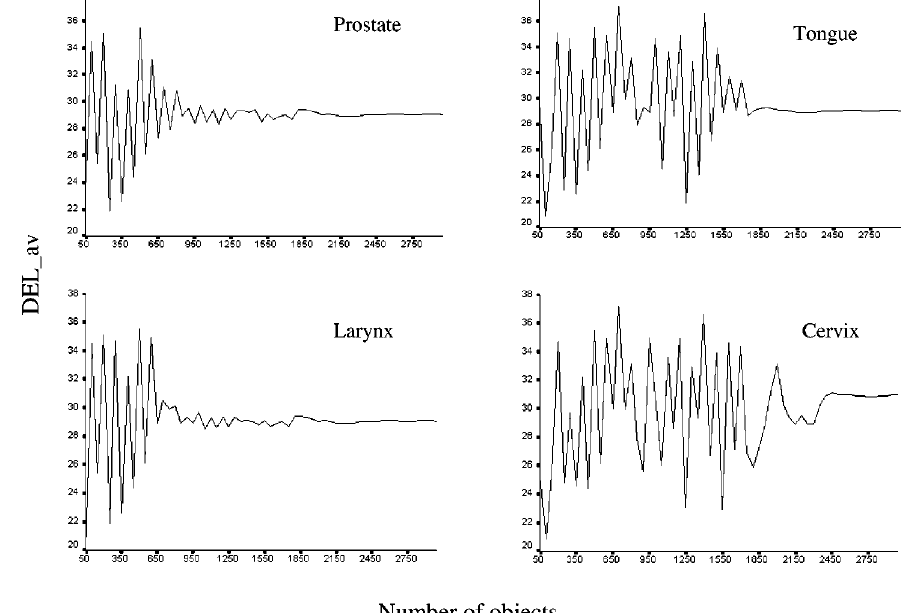
Fig. 2. The absolute values of the form parameter DEL_av as a function of the number of cells analyzed in four different tissues (carcinoma of the prostate, tongue, larynx and cervix). The number required to achieve reproducible values for a single structural feature varies considerably between tissues (approximately 800 cells in carcinoma of the larynx, 1200 cells in carcinoma of the prostate, 1800 cells in carcinoma of the tongue and approximately 2500 cells in carcinoma of the